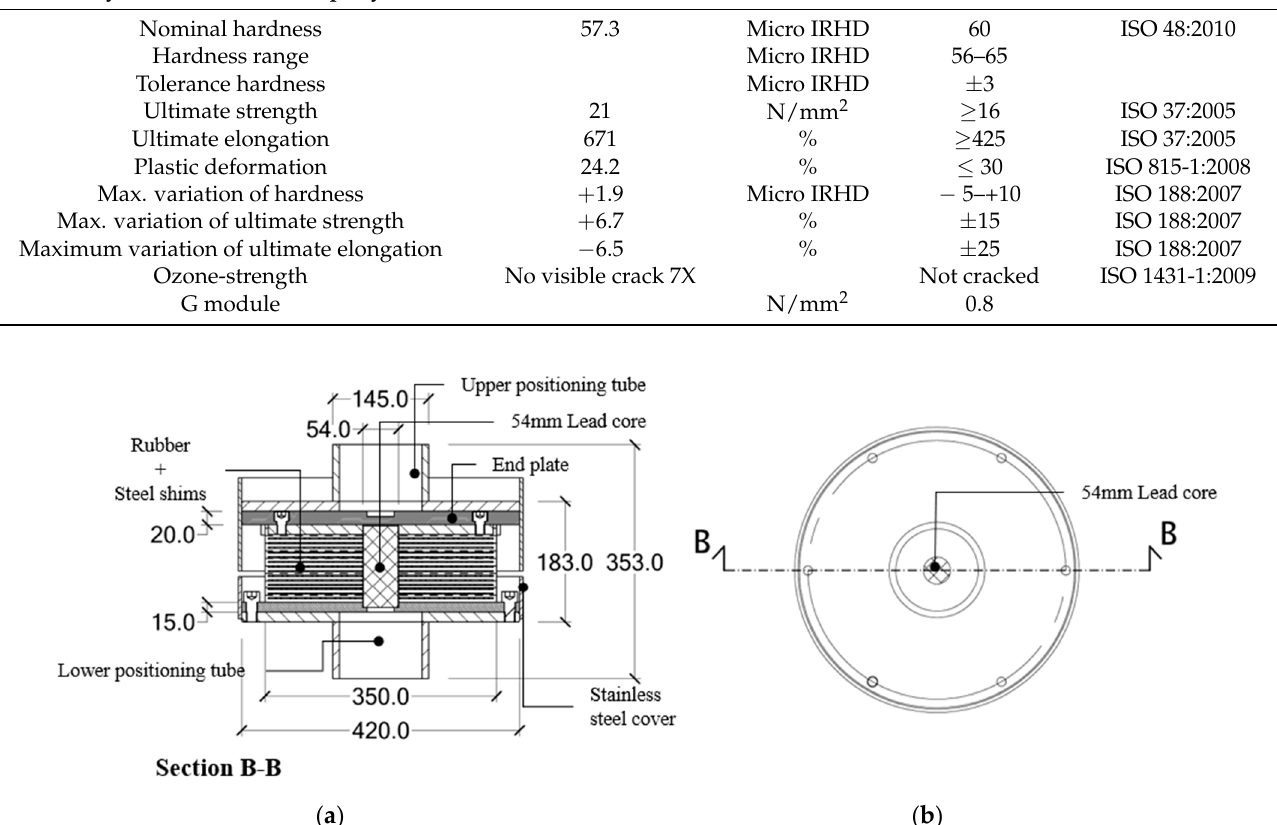
Figure 13. The adopted LRB isolator: ( a ) vertical section, and ( b ) horizontal plan view (all dimensions in mm).